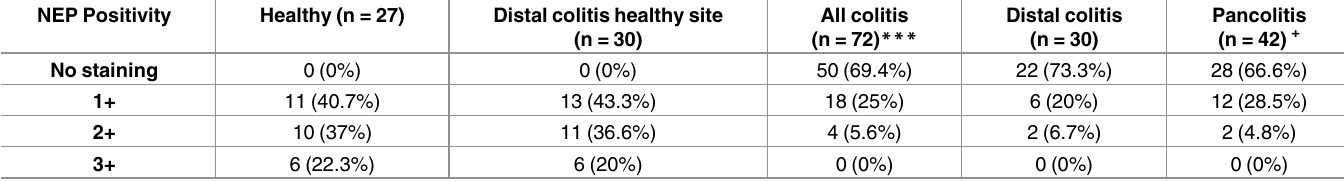
Table 2. Distribution of NEP positivity of patients with ulcerative colitis and healthy controls.